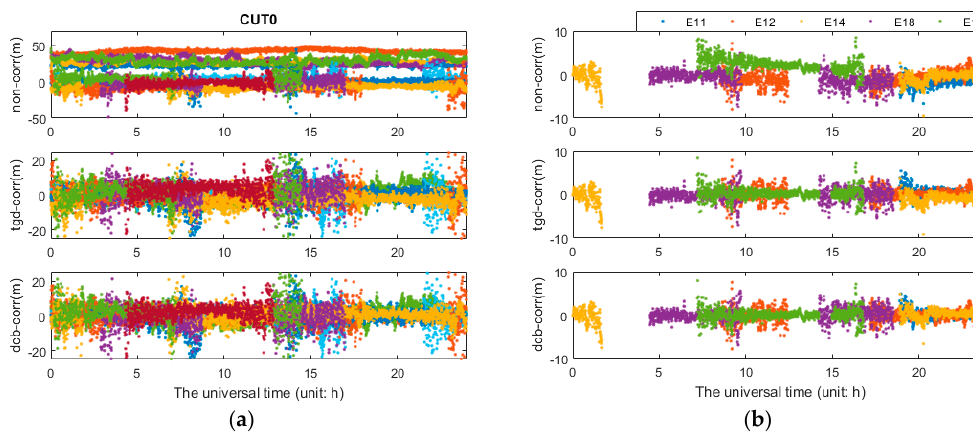
Figure 12. Pseudorange residuals of PPP solutions on CUT0 station: ( a ) description of b2b3 GPS/BDS/Galileo PPP solutions; and ( b ) description of b1b3 GPS/BDS/Galileo PPP solutions.